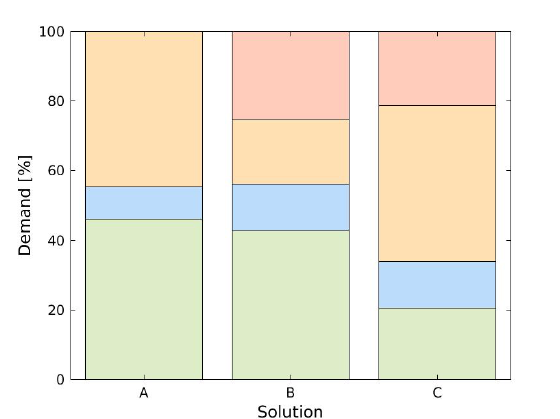
Figure 11. Demand distribution per DMAs for solutions A, B and C for MLN network. Code colors corresponding to DMAs of Figure